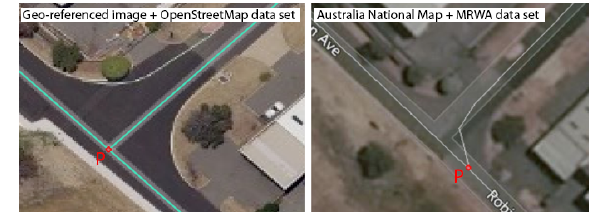
Figure 2. The picture on the left side shows a high-quality geo-referenced image with a data set of OSM, while the right image represents a National Map data set of the same junction with data from MRWA. The road connection points are indicated as ‘P’ (sources: http://spookfish.com (image left); http://openstreetmap.org (road data left); http://nationalmap.gov.au (image and road data